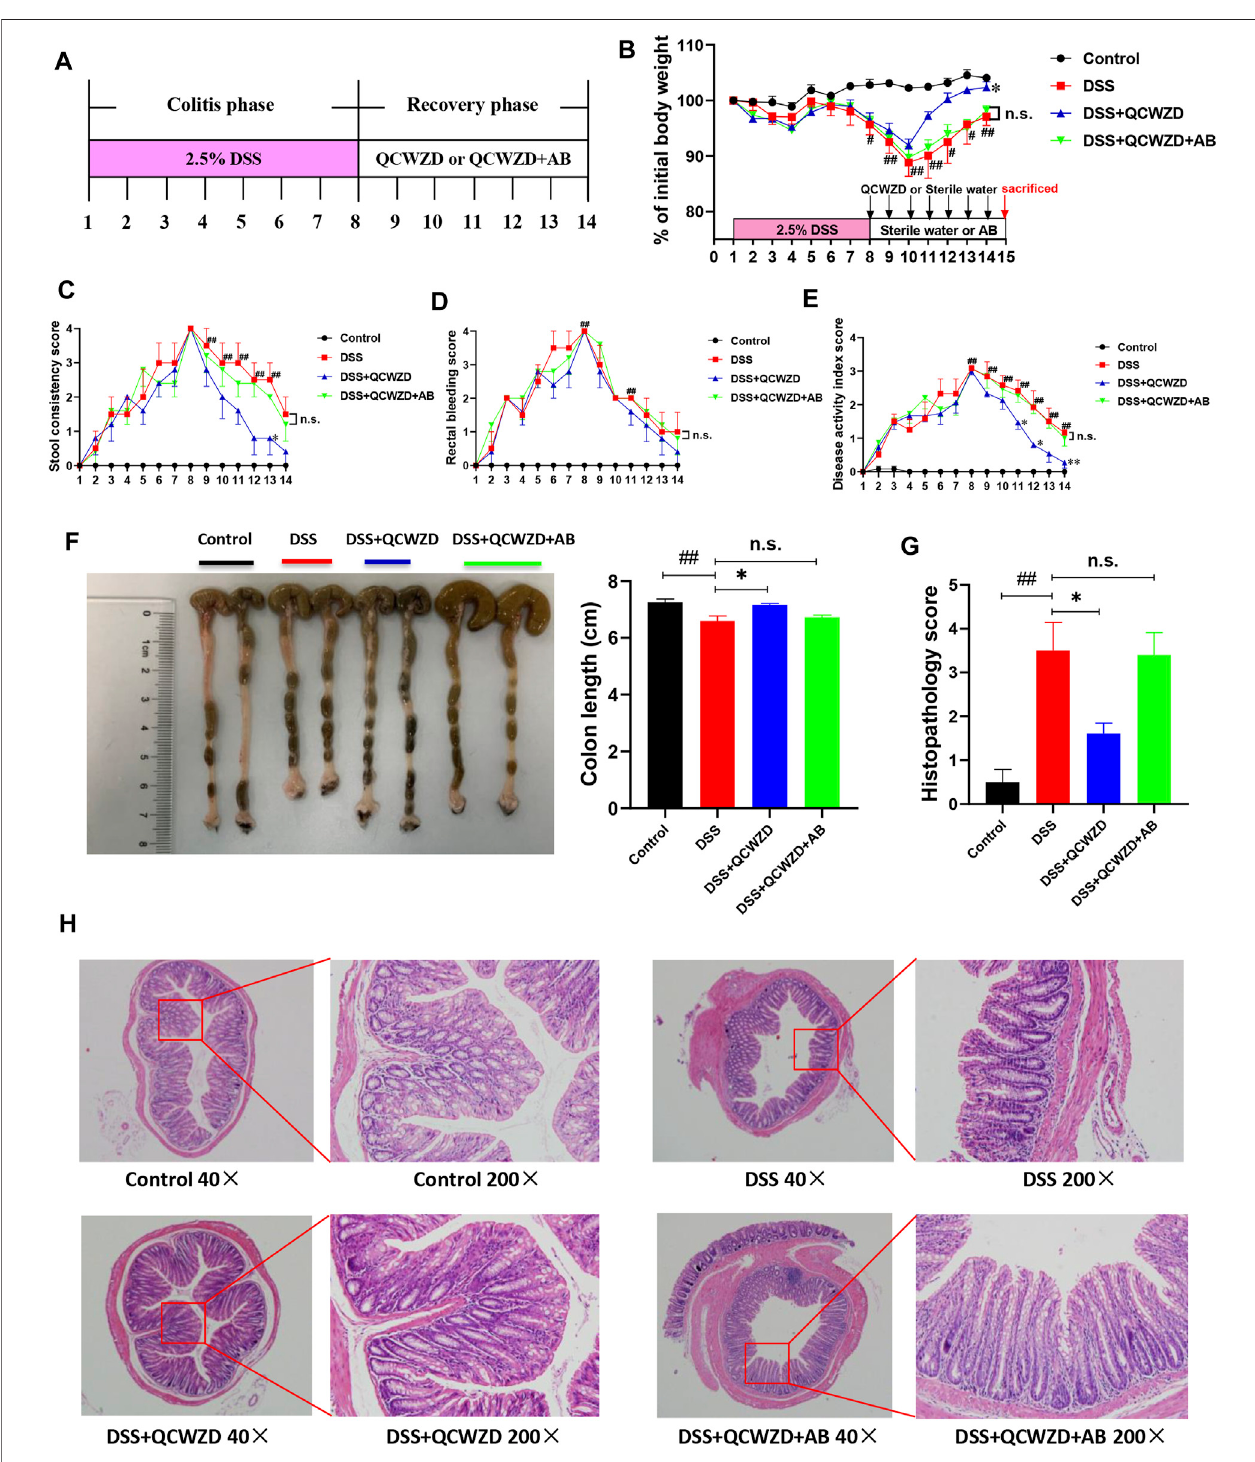
FIGURE5| AntibioticsTreatmentDiminishestheBene fi cialEffects ofQCWZDonColitisMice.Femalemice weregiven2.5%DSS(w/v)indrinkingwaterfor7days followed by one week treatment of QCWZD at a dose of 1.8 g/kg or sterile water in the presence or absence of antibiotics, then the clinical phenotypes were assessed. (A) Experimental design, (B) Body weight, (C) Rectal bleeding, (D) Stool consistency, (E) Disease activity index score, (F) Colon and colonic length, (G, H) Hematoxylin andeosin(H&E)stainingofthecolonandHistologicalscore.Thedatashownarethemean ± theSEM( n (cid:2) 4 – 5mice/group). ## p < 0.01, # p < 0.05versustheControl group; pp p < 0.01, p p < 0.05 versus the DSS group; n. s means no statistical signi fi cance. Signi fi cance was determined by one-way ANOVA test (Tukey ’ s multiple comparison test).